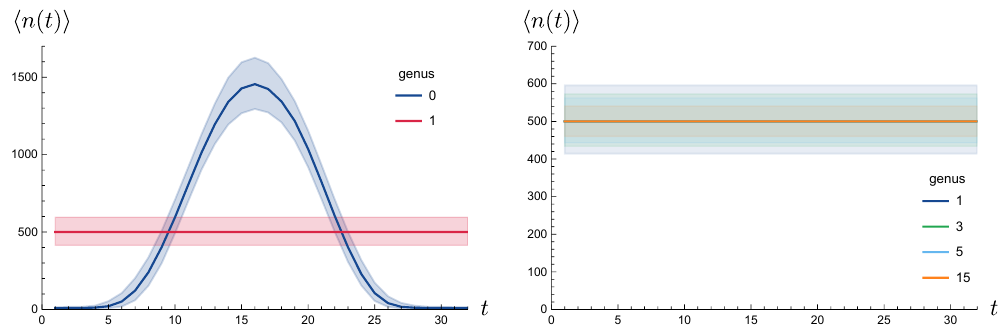
Figure 7. Left: the average volume profiles for the type III CDT ensemble with spatial genus 0 (blue) and spatial genus 1 (red). Right: the average volume profiles for the type III CDT ensemble with spatial genus g = 1 , 3 , 5 , 15 , which are seen to coincide. The shaded regions indicate the typical size of the fluctuations around the mean, where the width of the band decreases with increasing